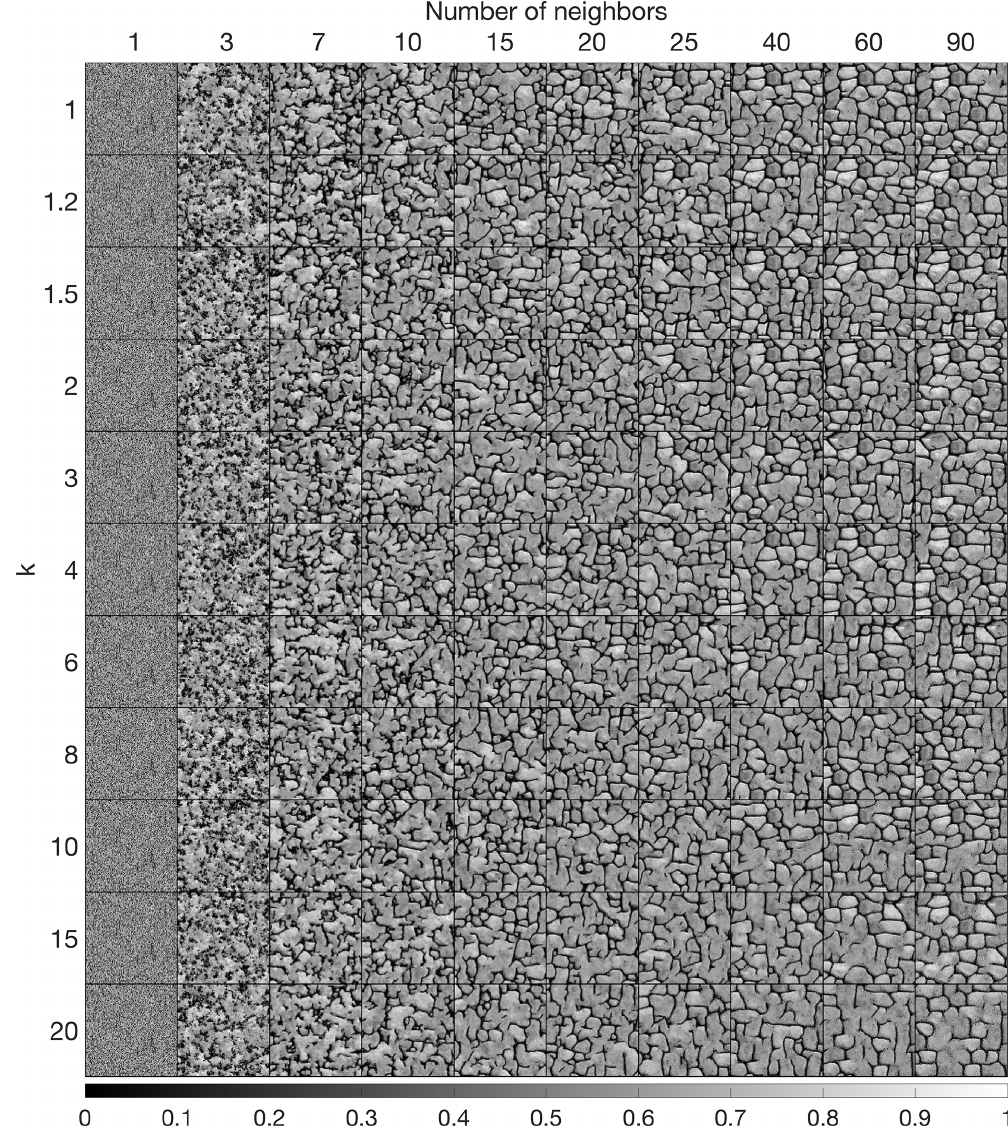
Figure A4. Complete sensitivity analysis, with one simulation for the two main parameters of QS.